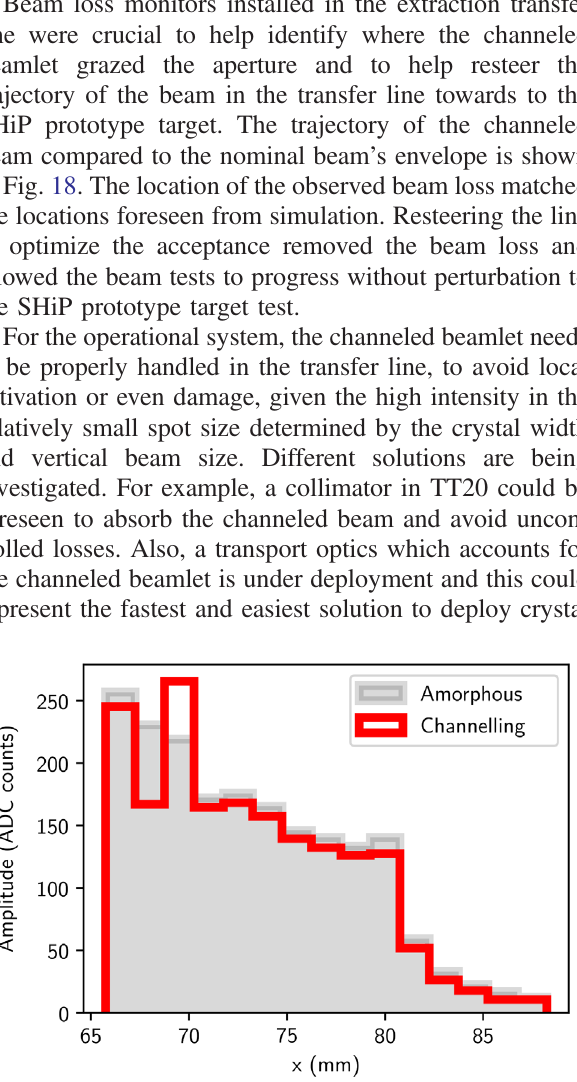
FIG. 17. Horizontal beam intensity distribution measured on a wire-grid beam profiler located immediately in front of the